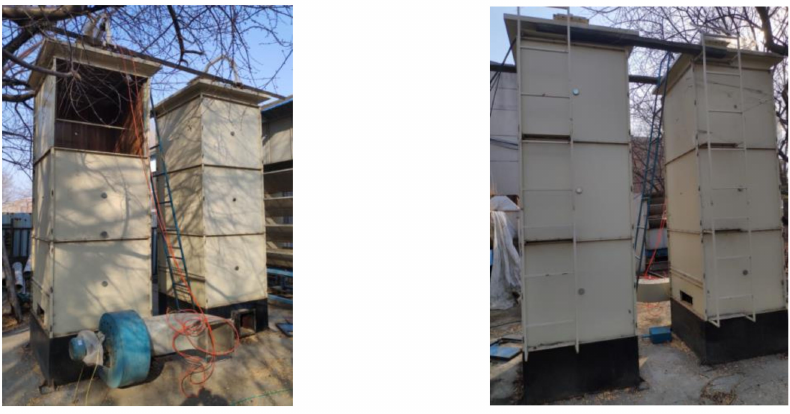
Figure 20. Granary application scene